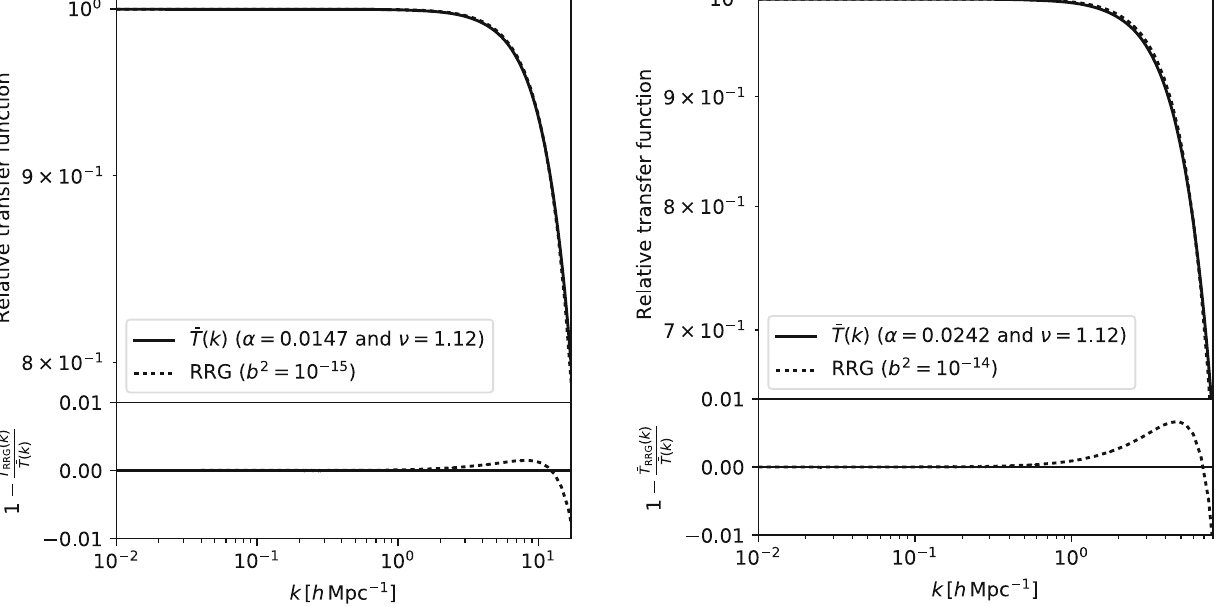
Fig. 5 Top left: Plots for ¯ T RRG ( k ) with b 2 = 10 − 15 and ¯ T ( k ) with α = 0 . 0147 and ν = 1 . 12. Top right: ¯ T RRG ( k ) with b 2 = 10 − 14 and ¯ T ( k ) with α = 0 . 0242 and ν = 1 . 12. Bottom left and right: relative error for both